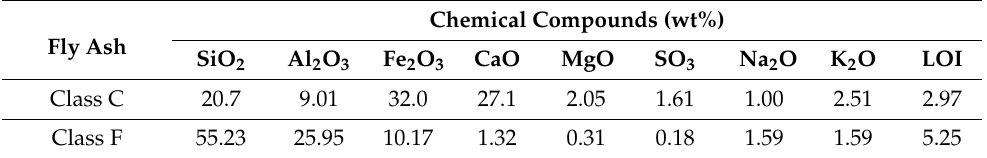
Table 1. Chemical composition of fly ash and source data from